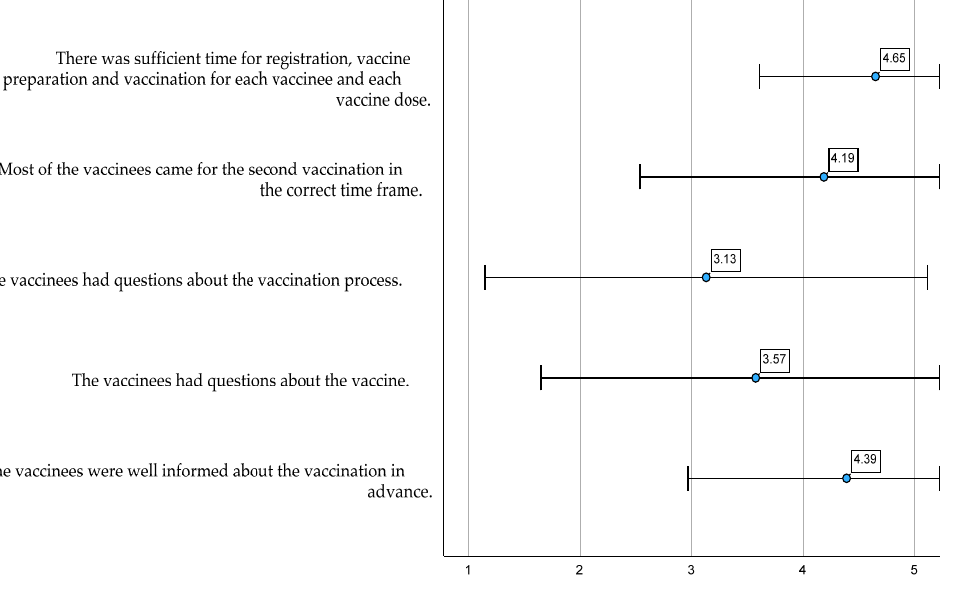
Figure 5. Perception of the vaccination centre staff of the information provision prior to inoculation.